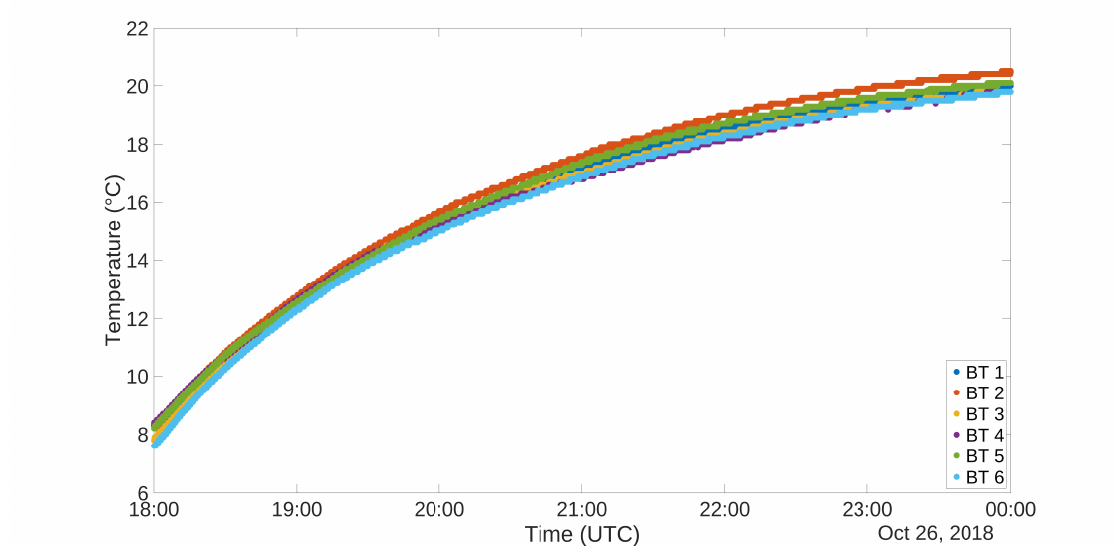
Figure 9. DHT22 Refrigerator test, Temperature ( ◦